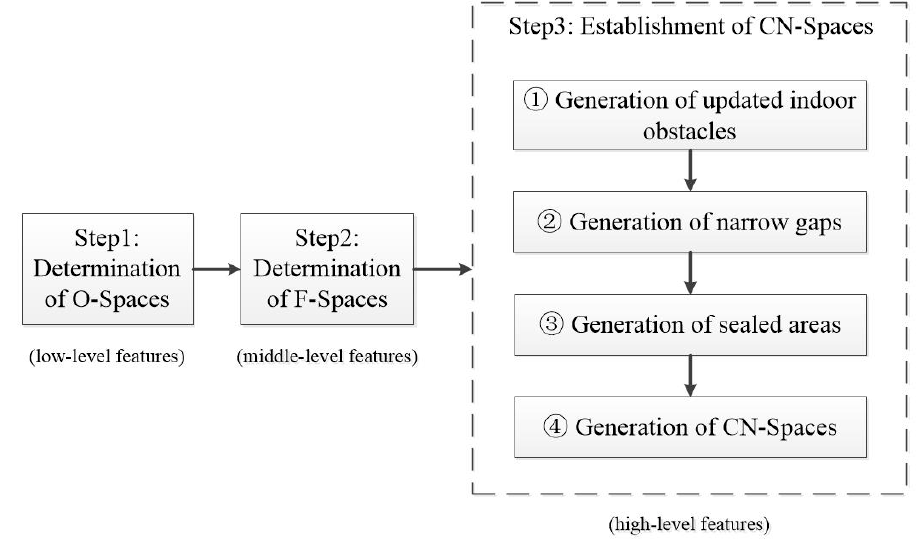
Figure 1. The flow chart of the generation process of CN-Spaces (comfortable navigable spaces).